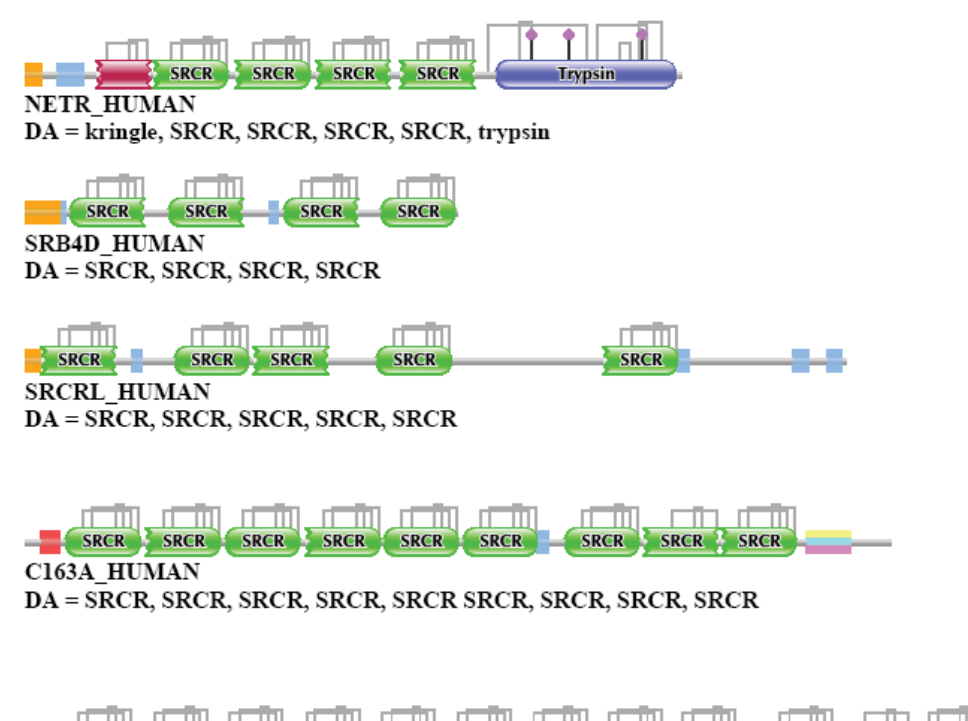
Figure S3. Comparison of the domain architectures of NETR_HUMAN and its closest human epaktologs.